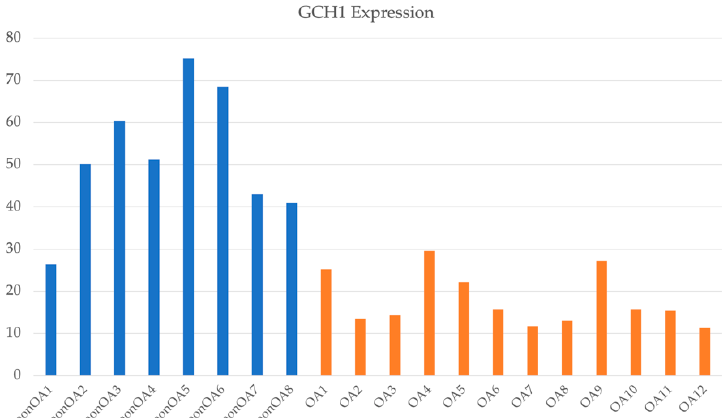
Figure 3. GCH1 expression in samples from 8 non-OA patients and 12 OA patients. OA: osteoarthri-